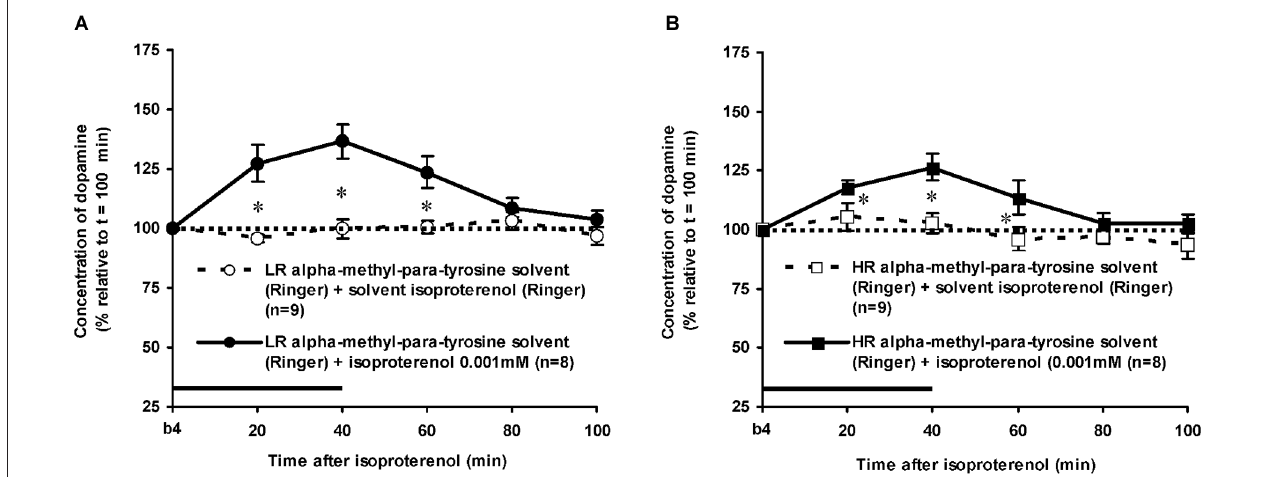
expressed as percentage of the sample collected just before ISO was infused (basal sample b4 of Figure 3 ). Data are expressed as mean percentage ± SEM. The solid horizontal line represents the infusion time of ISO. * Significant DA increase after ISO (Student’s t -test).